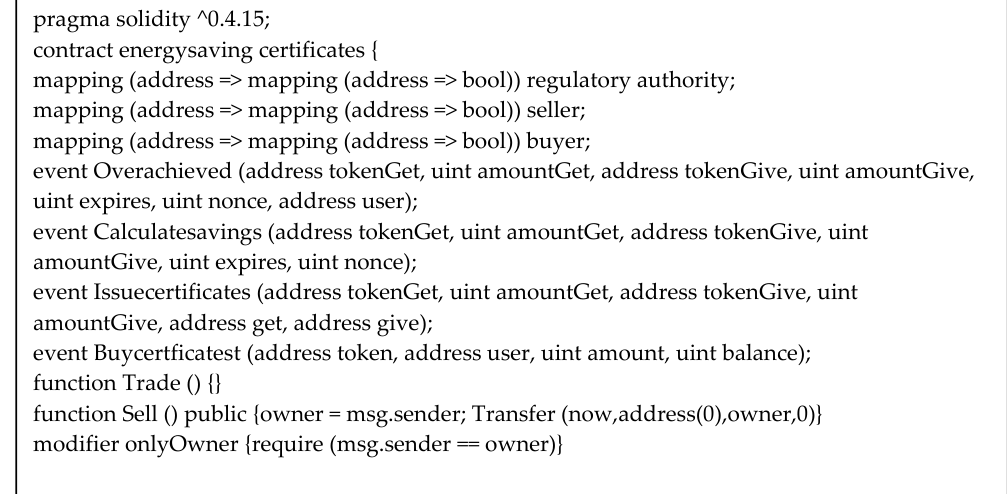
Figure 8. Ethereum transactions workflow.